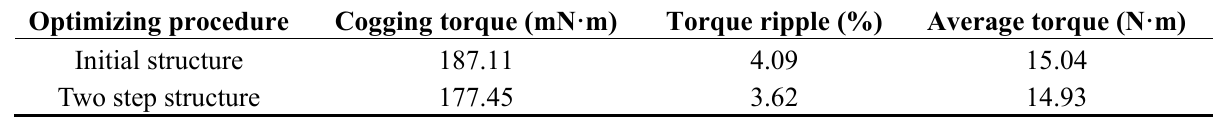
Table 3. Torque characteristics before and after the stepped teeth optimization.